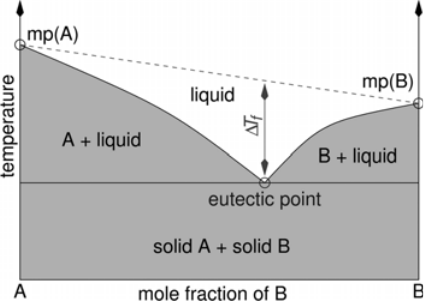
Figure 2. Schematic representation of the eutectic point in a binary (A + B) phase diagram [16].